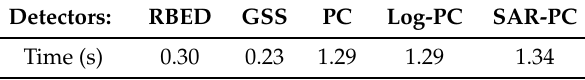
Table 2. Running time of each